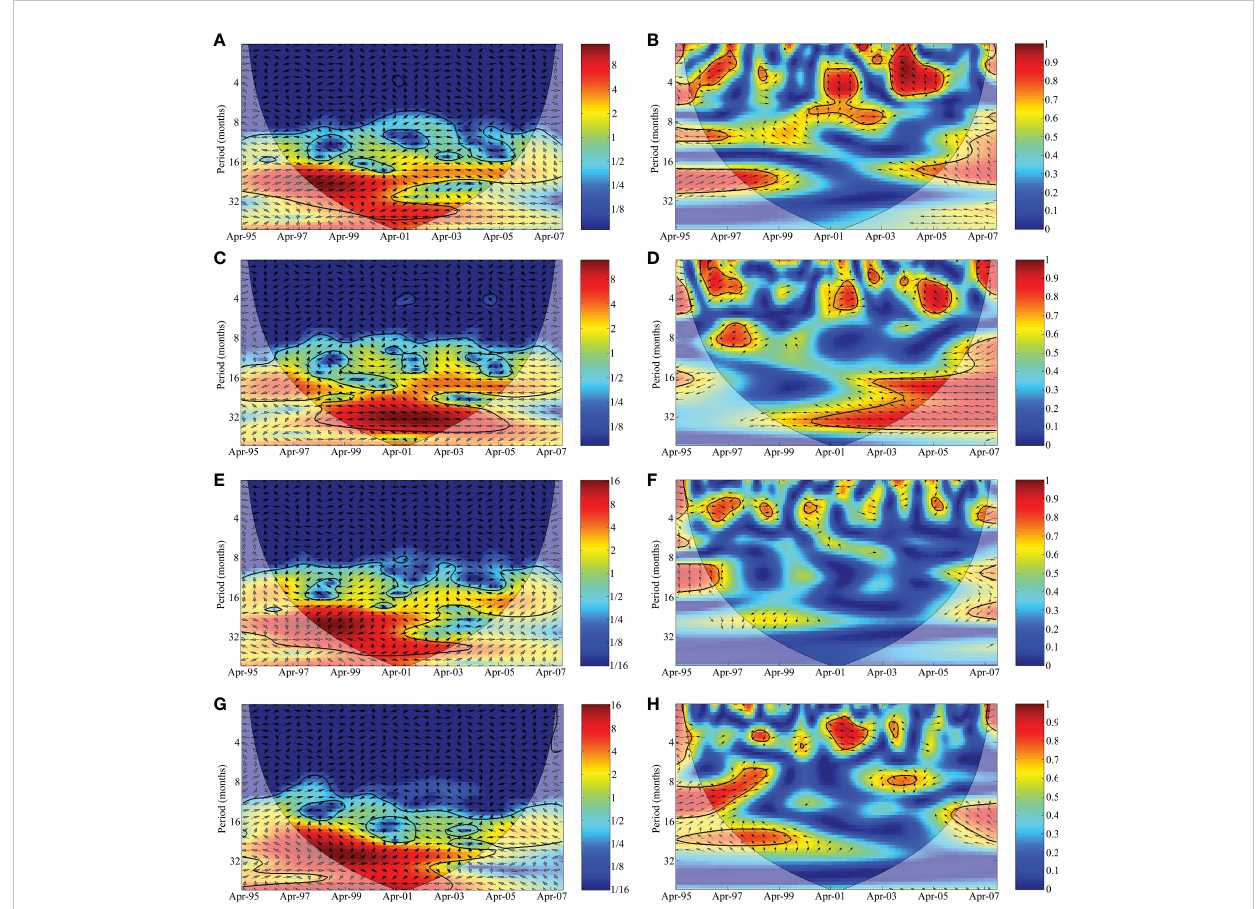
FIGURE 6 Cross-wavelet and coherence wavelet analysis between the shark bycatch landed by the acoupa weak fi sh ( Cynoscion acoupa ) gillnet fi sheries in Para ́ state and the anomalies of (A, B) sea surface temperature (SST), (C, D) the meridional wind component (v), (E, F) the discharge of the Amazon River (ARD), and (G, H) the Atlantic multidecadal oscillation (AMO). The contours outline the variance units, and the 5% signi fi cance level for red noise is shown as a thick contour (the cone of in fl uence). The relative phases are shown as vectors.